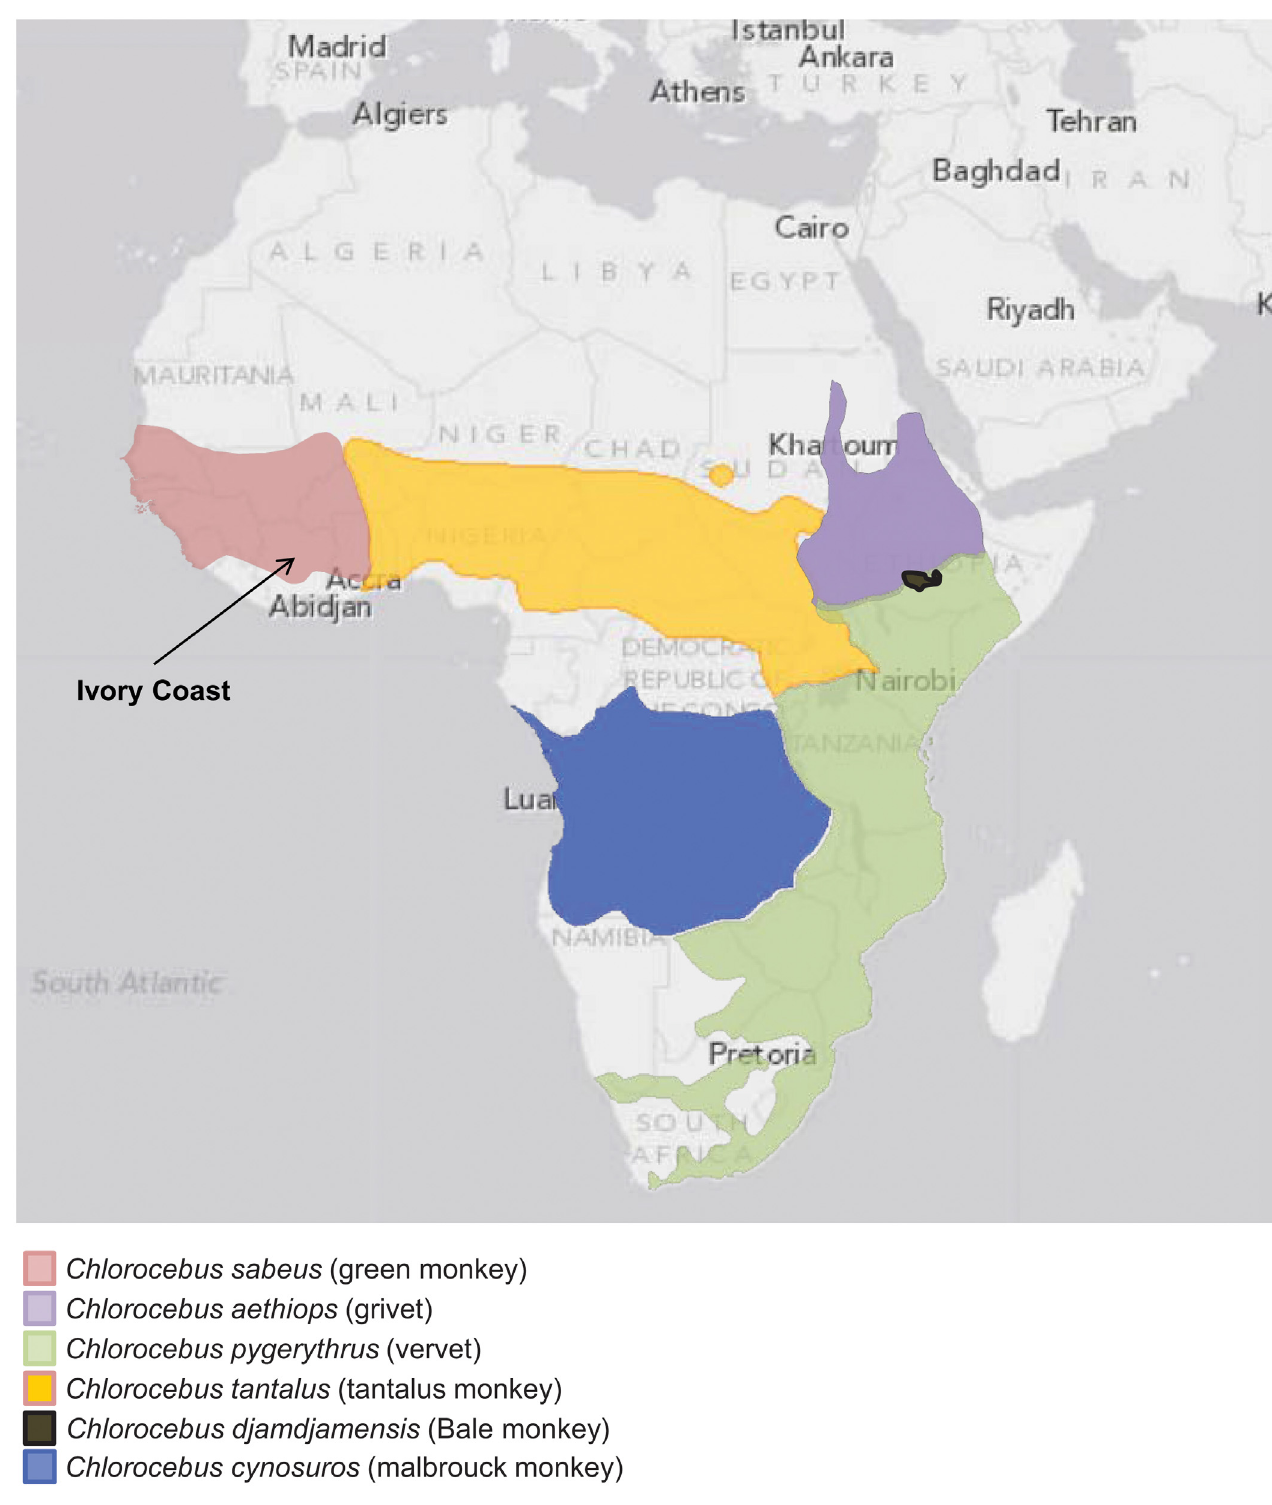
Fig 2. Distribution of African green monkeys ( Chlorocebus species) in Africa. Chlorocebus classification and ranges are from the International Union for Conservation (IUCN) of Nature Red List (http://www.iucnredlist.org/search) downloaded Nov. 18, 2015.